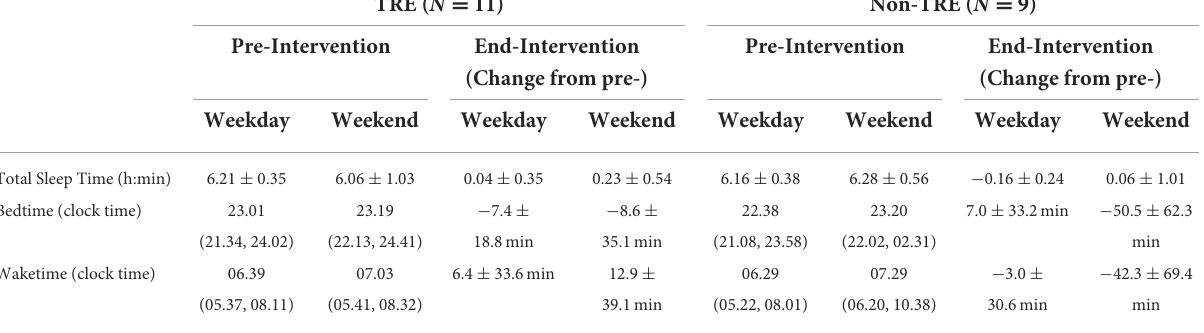
TABLE 3 Pre-intervention and change from pre- to end-intervention for actigraphy-estimated sleep by group. TRE ( N = 11) Non-TRE ( N = 9) Pre-Intervention End-Intervention Pre-Intervention End-Intervention (Change from pre-) (Change from pre-) Weekday Weekend Weekday Weekend Weekday Weekend